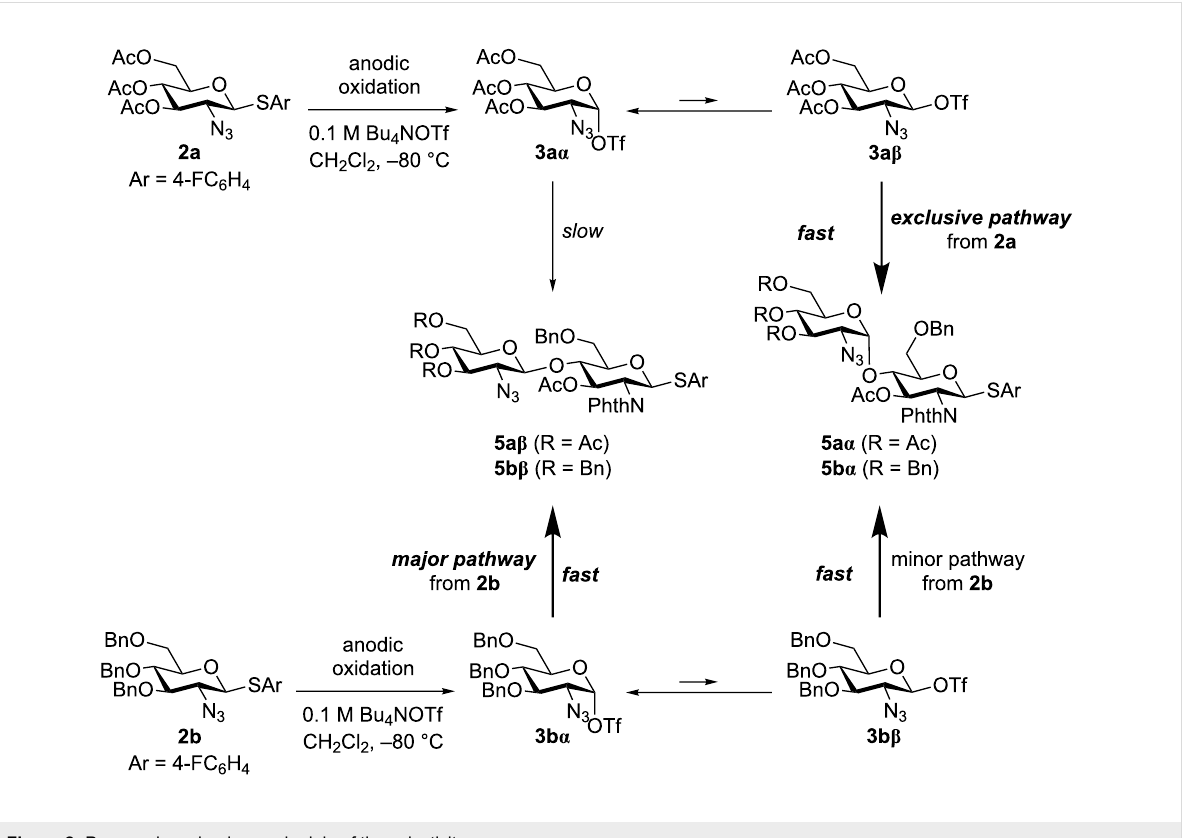
Figure 2: Proposed mechanism and origin of the selectivity.